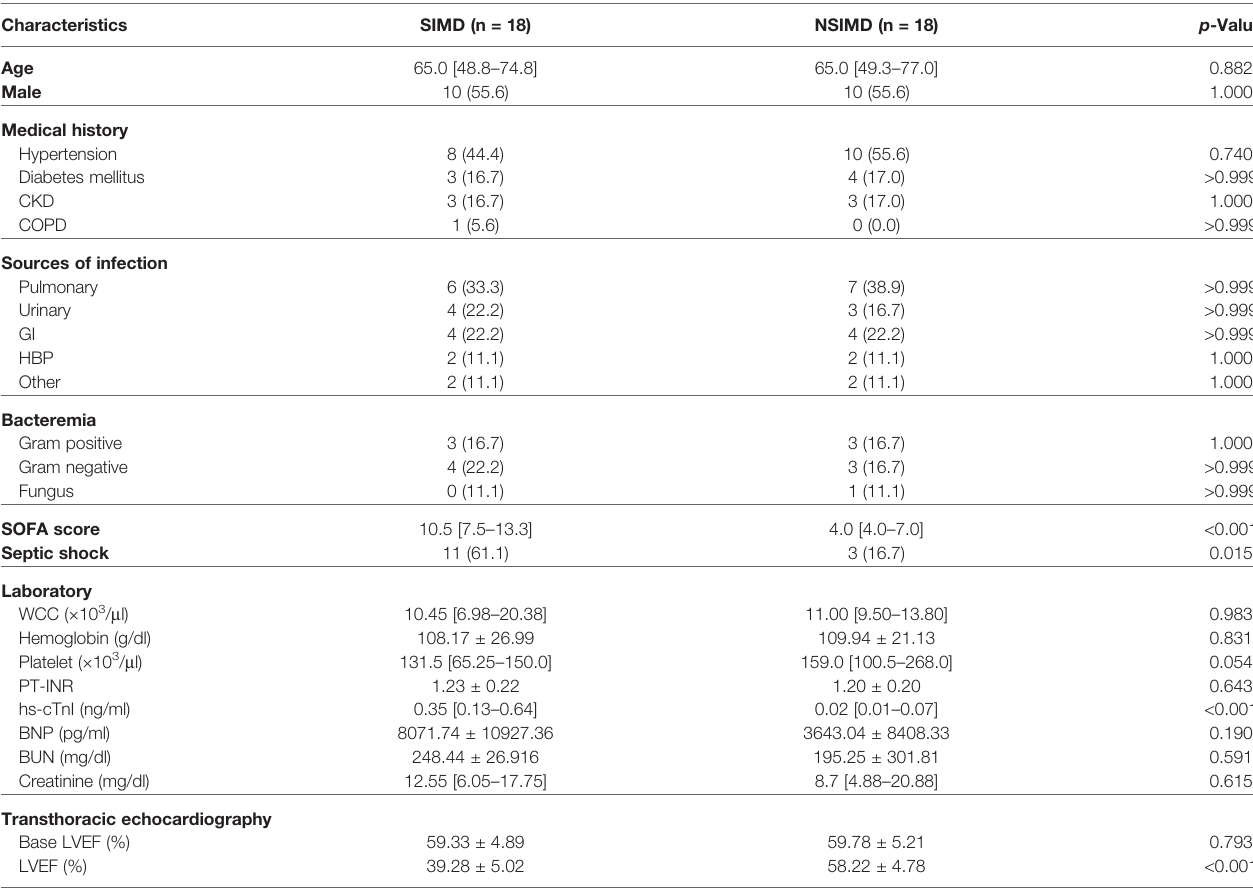
TABLE 1 | Matched patient